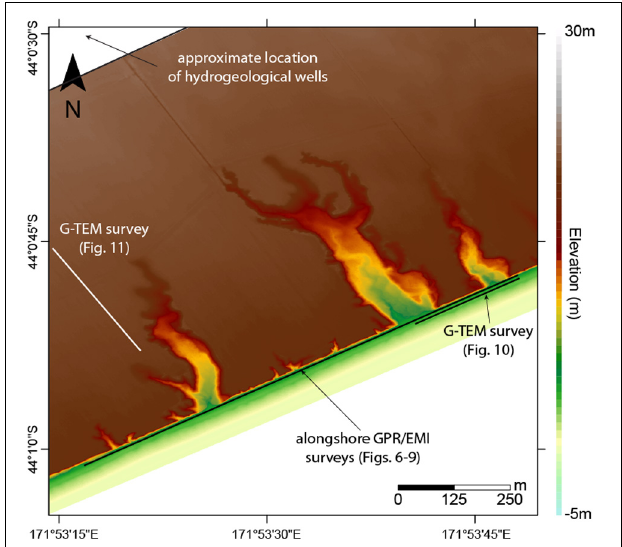
FIGURE 4 | DEM of the study area showing the georeferenced locations of the GPR, EMI, and G-TEM surveys. Approximate locations of the closest hydrogeological wells ( ∼ 1 km inland from the coastline) are indicated in the upper left hand corner. The source for the LiDAR data used to produce the DEM is: https://www.linz.govt.nz/.